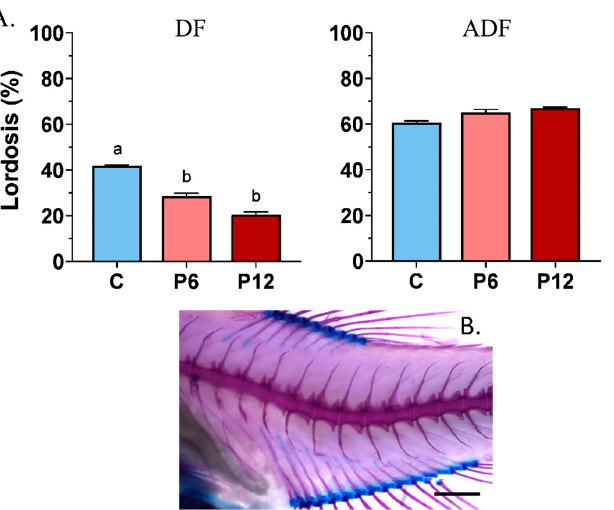
Figure 6 . Frequency of haemal lordosis ( A ) after the SCT between the experimental diets (C, P6, P12) among the two feeding regimes tested (DF, ADF). A representative case of haemal lordosis is pre- sented below the graphs ( B ). Statistically signi fi cant di ff erences between the diets are indicated by the absence of a common le tt er ( p < 0.05). Error bars equal to 1 s.e. Scale bar equals 0.5 mm.